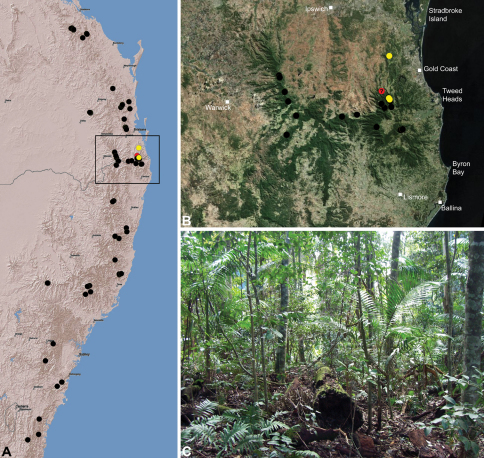
Austrarchaea dianneae sp. n., distribution and habitat: A, topographic map showing the known distribution of Archaeidae in south-eastern Queensland and eastern New South Wales, with collection localities for A. dianneae highlighted in yellow; B, satellite image showing detail of inset (A); C, subtropical rainforest at the type locality – Joalah Section, Tamborine National Park, Queensland (June 2009). Note the sympatric occurrence of this species with A. nodosa on the ‘scenic rim’ at Binna Burra, Lamington National Park. Image (C) by M. Rix.